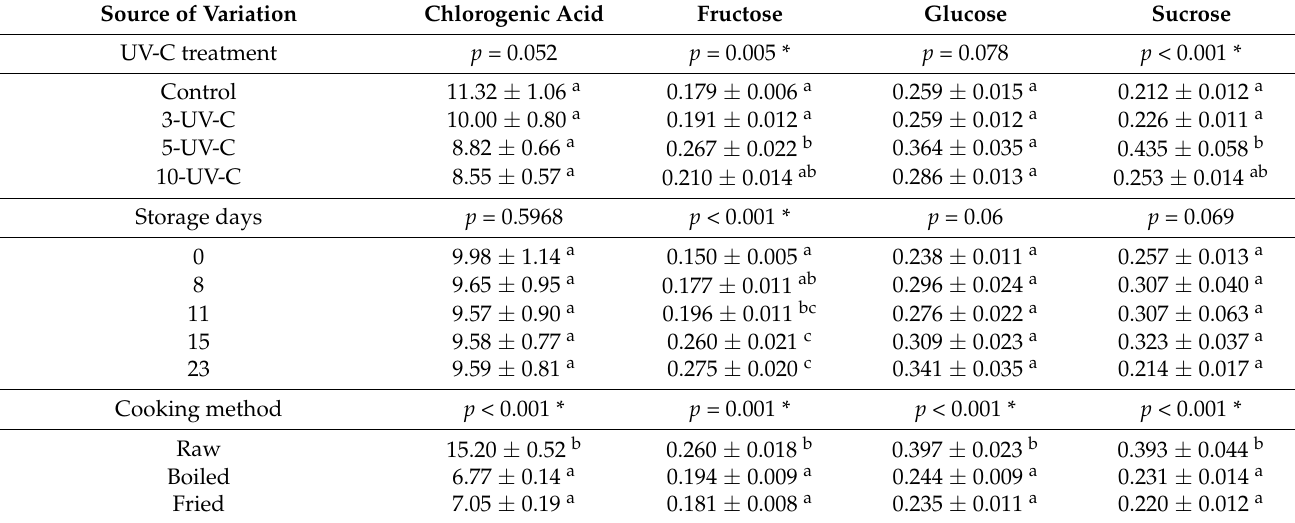
Table 1. The influence of UV-C treatment, storage days, and cooking method on chlorogenic acid (mg 100 g − 1 DW) and sugars (g 100 g − 1 DW) in fresh-cut